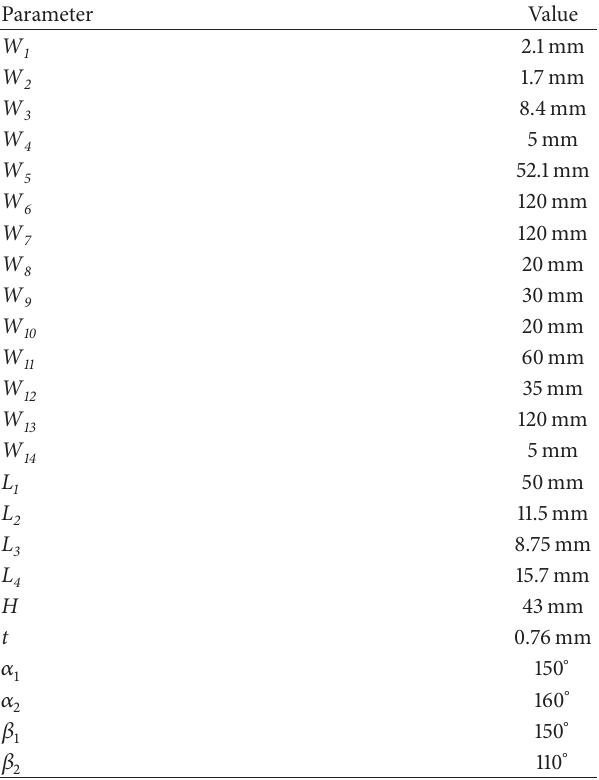
Table 1: Geometric parameters optimized for the V/H dual- polarized antenna.